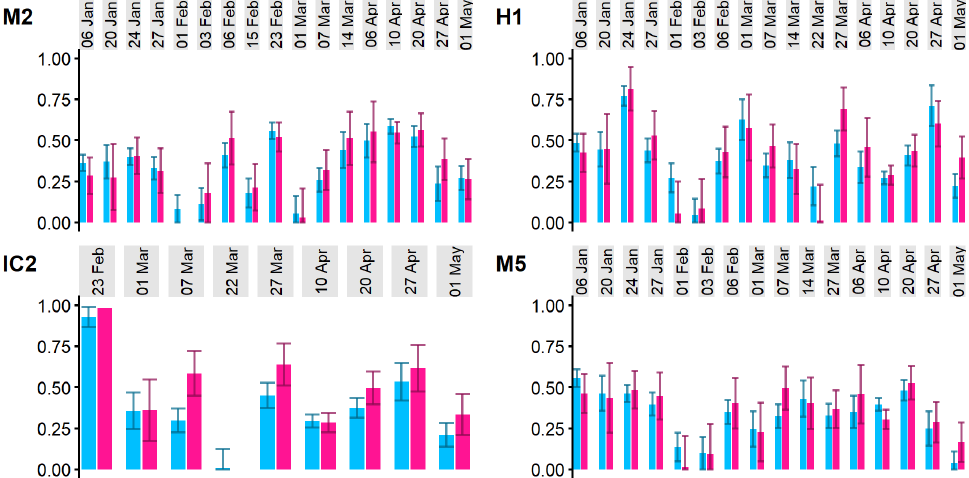
Figure 5. Isotope mixing model results showing fraction of Cosumnes on the y-axis for δ 2 H (blue) and δ 18 O (pink), along with instrument error bars at four example locations (depicted in Figure 3) in 2017. M2 Downstream of confluence. H1: Dead Horse Cut. IC2: Island site C2. M5: South Fork Mokelumne.